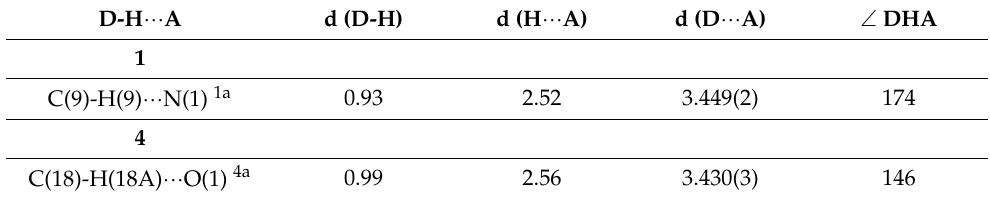
Figure 5. The molecular structure of 4 with atom labelling. Displacement ellipsoids are drawn at the 30% probability level. Table 1. Hydrogen bonding